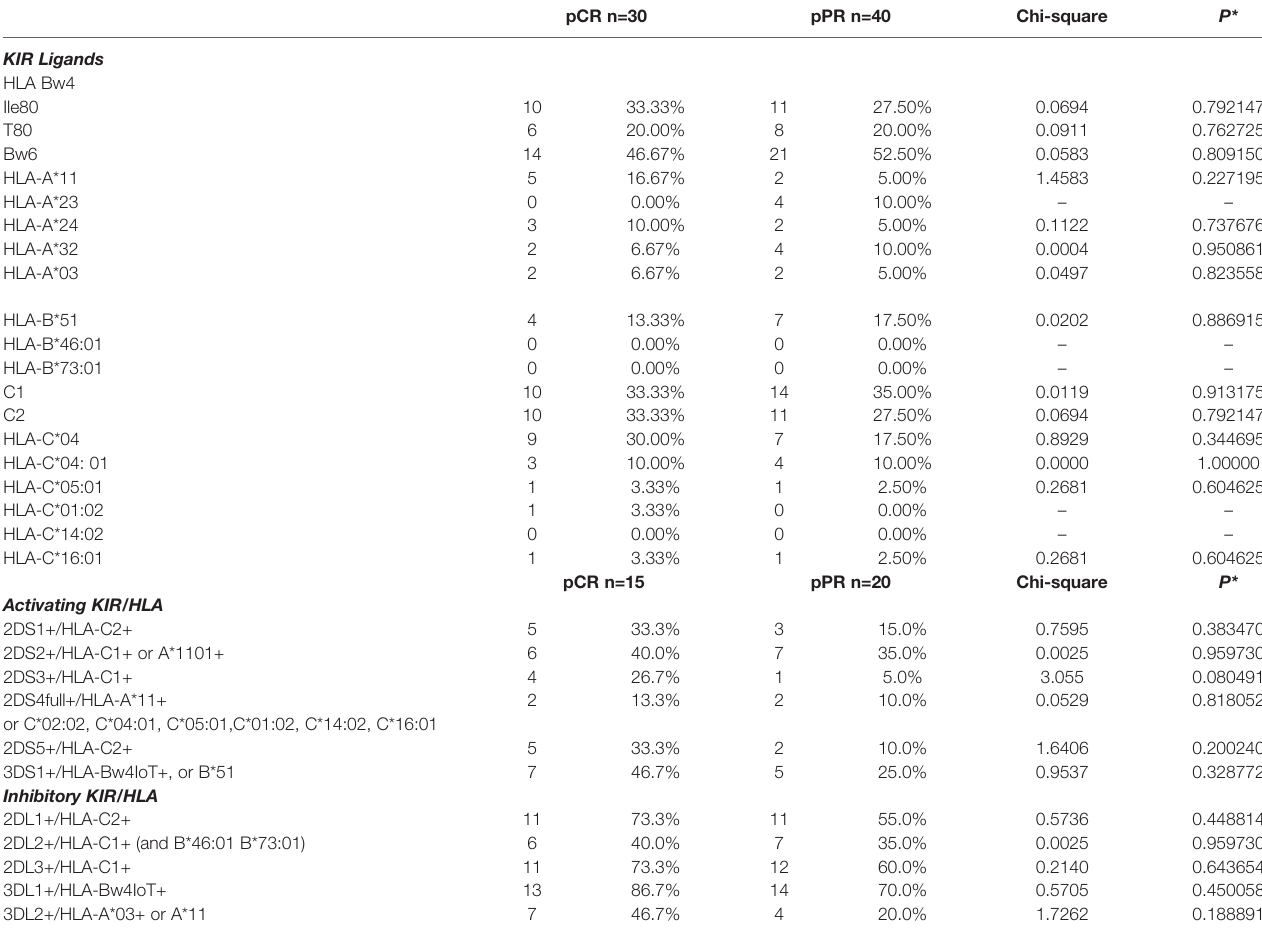
TABLE 4 | Comparisons of KIR genes and their cognate HLA ligands between CR and PR